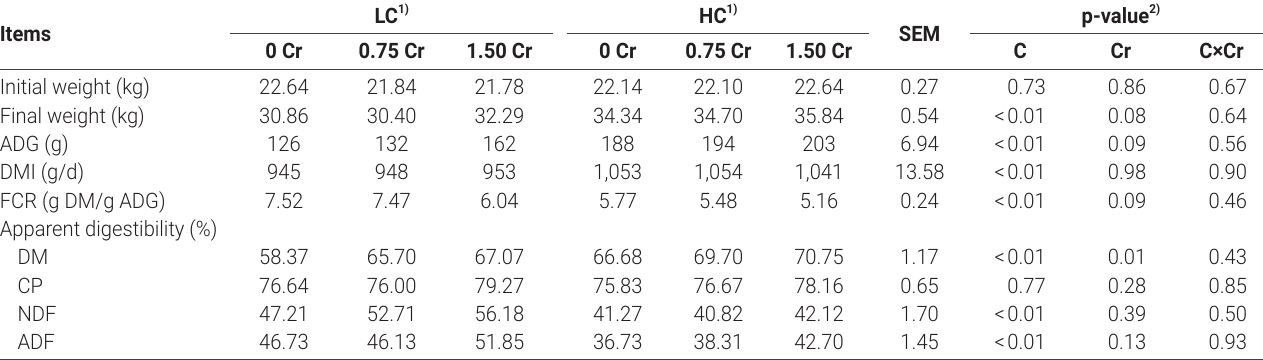
Table 3. Effects of concentrate level and Cr-Met supplementation on growth performance and nutrient digestibility of Tan lambs